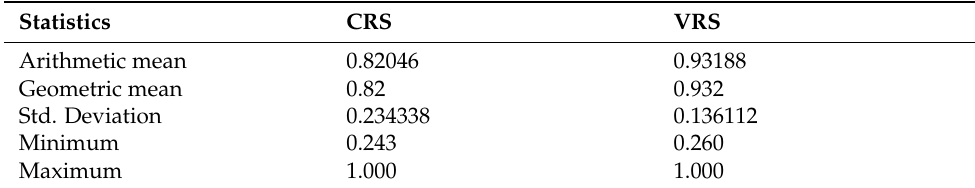
Table 3. Summary table of the efficiencies (total